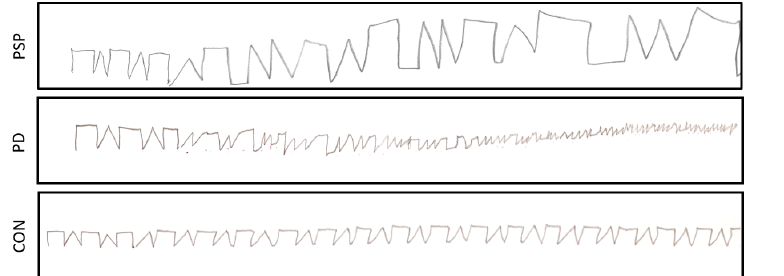
Figure 8. LAST execution examples in three different groups: Parkinson’s disease (PD), progressive supranuclear palsy (PSP), and neurologically intact